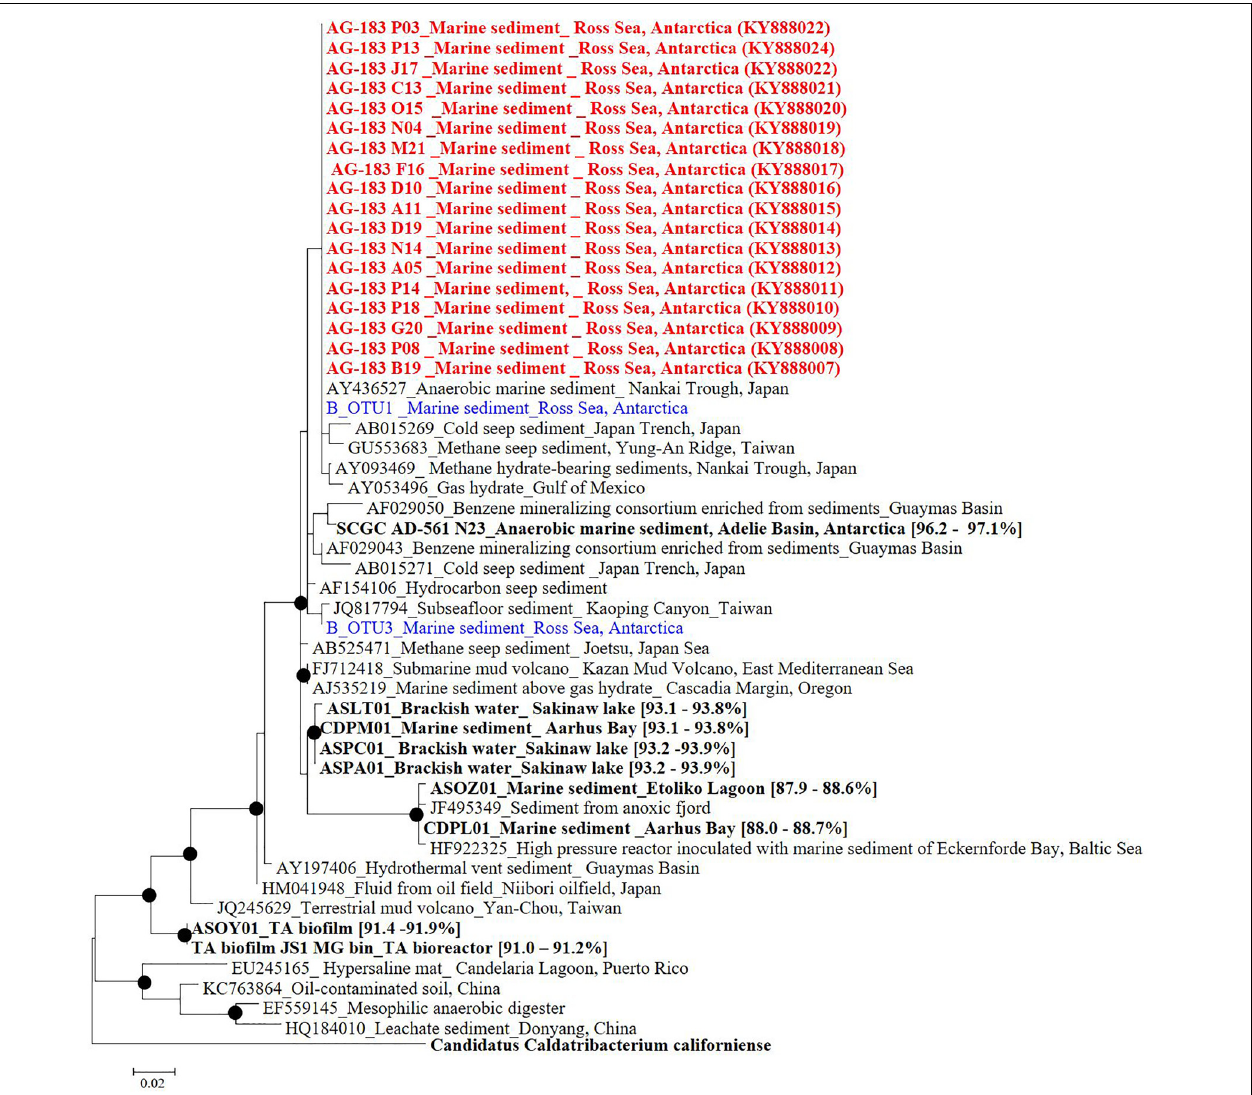
FIGURE 3 | Phylogenetic tree based on 16S rRNA gene sequences from Candidatus Atribacteria JS1 lineage. Red colored sequences represent sequences retrieved from single-cell genomes obtained in this study while blue colored sequences were obtained by pyrosequencing of 16S rRNA amplicons in this study. B_OTU1 and B_OTU3 were the most abundant Ca. Atribacteria JS1 sequences. Sequences from other studies are indicated with GenBank accession ID numbers, the habitats, and location of the organisms from which the sequences were obtained. Bold sequences were obtained from single-cell genomes or metagenomes and values in parentheses are the 16S rRNA gene sequence similarity with those from single-cell genomes obtained in this study. Filled circles indicate that the corresponding nodes had > 70% bootstrap values based on 1,000 resamplings. Ca. Caldatribacterium californiense that belongs to the OP9 lineage of Atribacteria was used as an